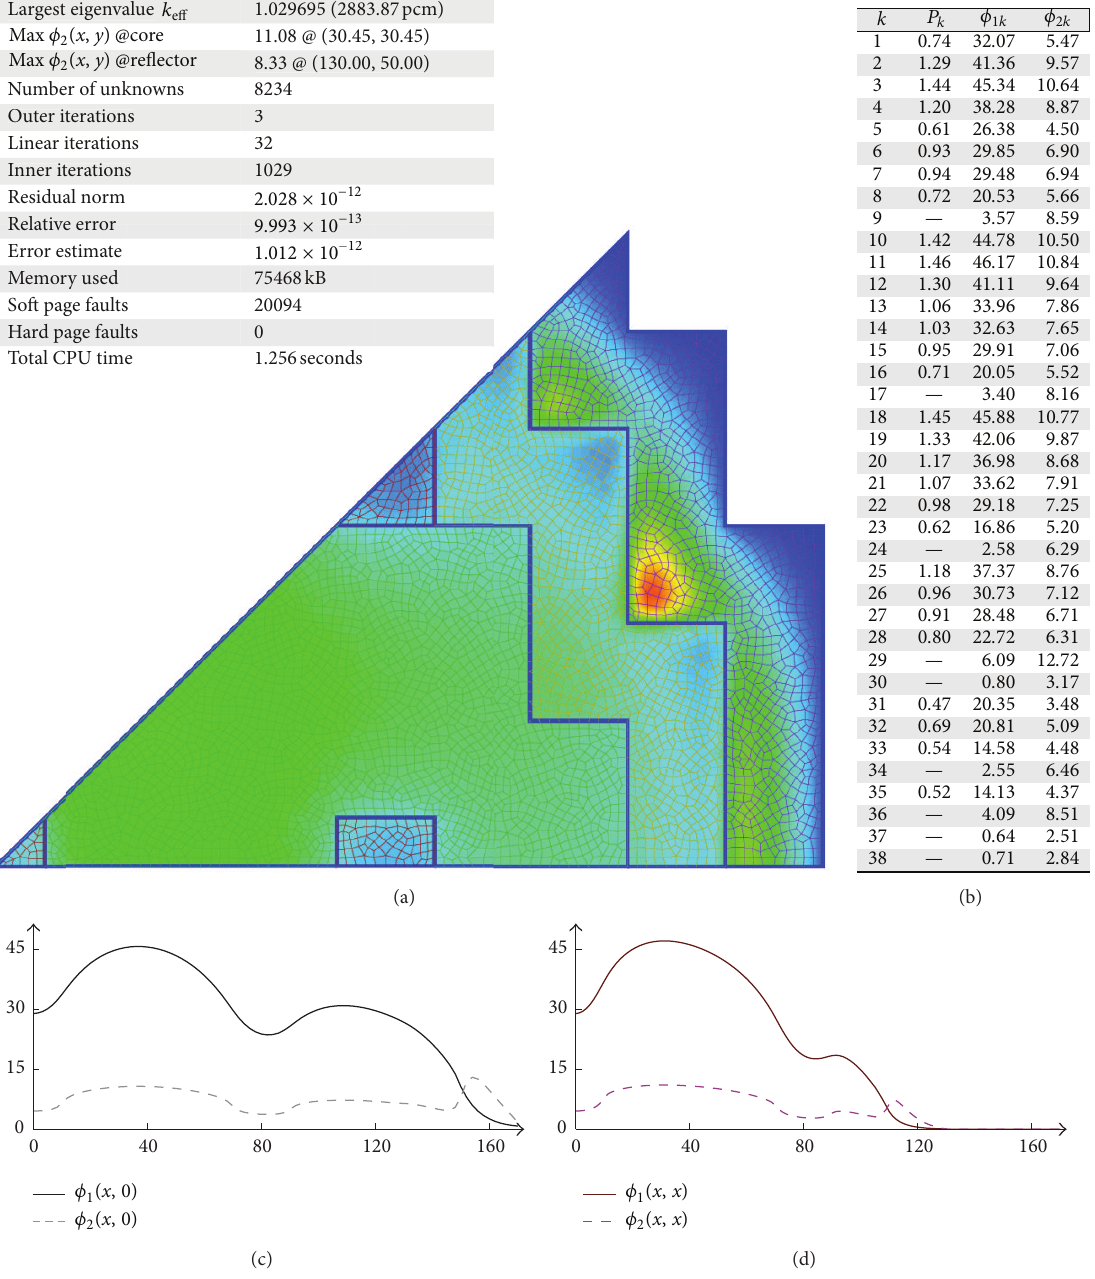
Figure 16: (a) Mesh and thermal flux distribution. (b) Power and fluxes. (c) Flux distribution 𝜙 𝑔 (𝑥,0) along the 𝑥 -axis. (d) Flux distribution (𝑥,𝑥) along the 𝜙 𝑔